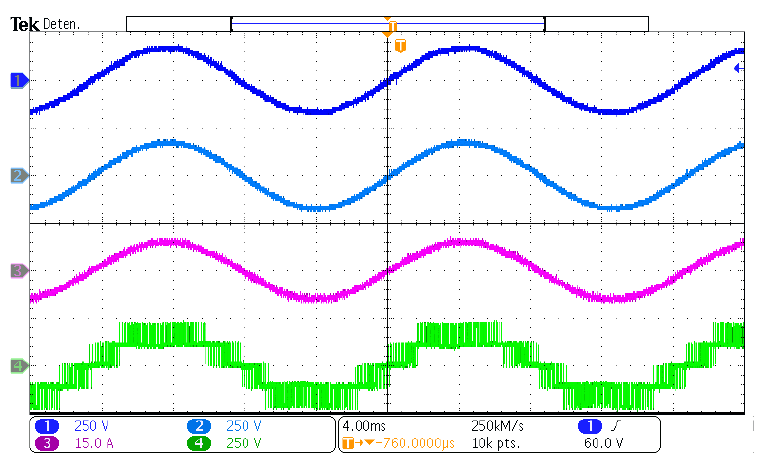
Figure 13. Steady state responses of: (CH1) the grid voltage v PCC (y-axis 250V/div); (CH2) the fundamental component estimate of the grid voltage v PCC,1 (y-axis 250V/div); (CH3) the line current i G (y-axis 15 A/div); and (CH4) the multilevel output voltage generated by the VSI e AF (y-axis 250